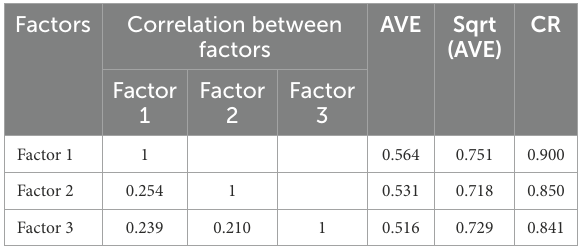
TABLE 3 Convergent validity and discriminant validity of the FH